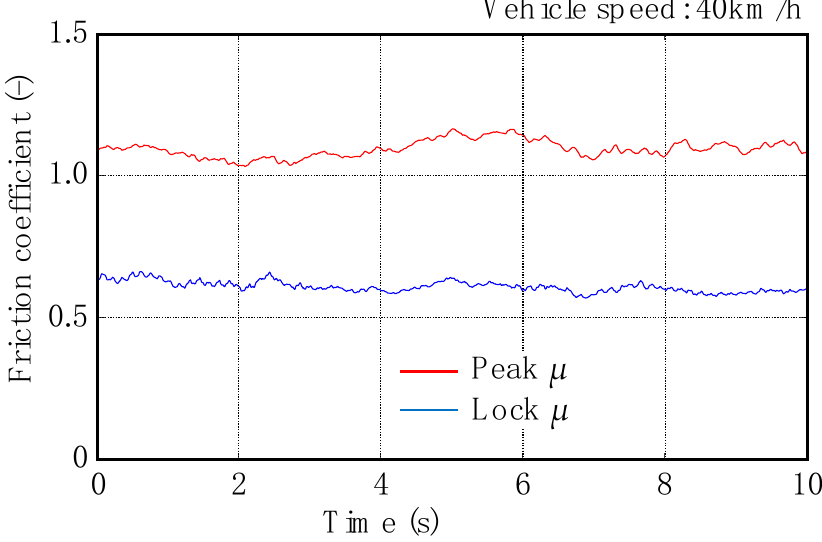
Figure 21. Continuous measurement results of peak μ and lock μ .